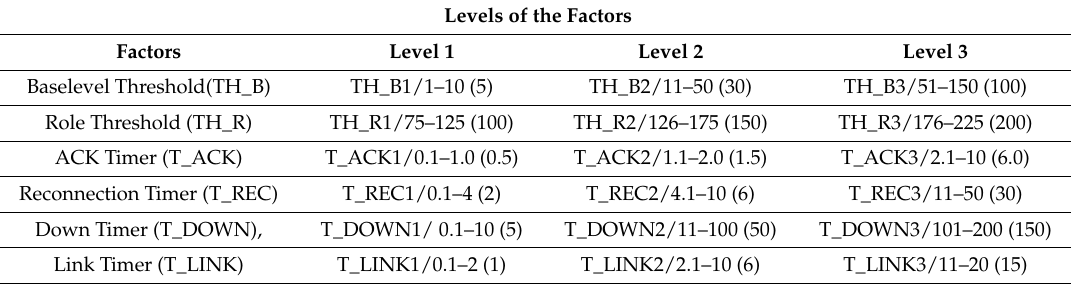
Table 2. Selection of the different intervals or levels in which the different numerical values of the main factors were categorized to analyze the behavior of the DARP